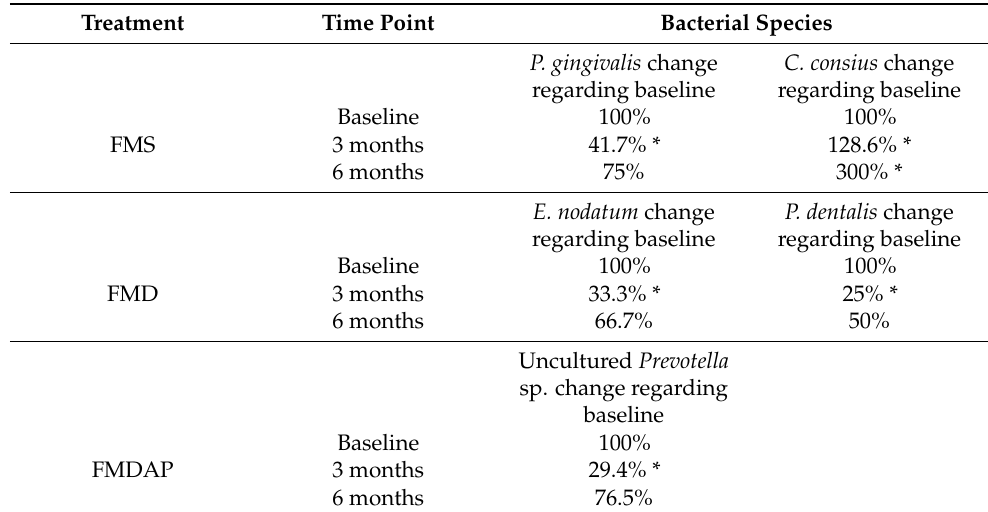
C. consius change regarding baseline 100% 128.6% * 300% * P. dentalis change regarding baseline 100% 25% * 50%